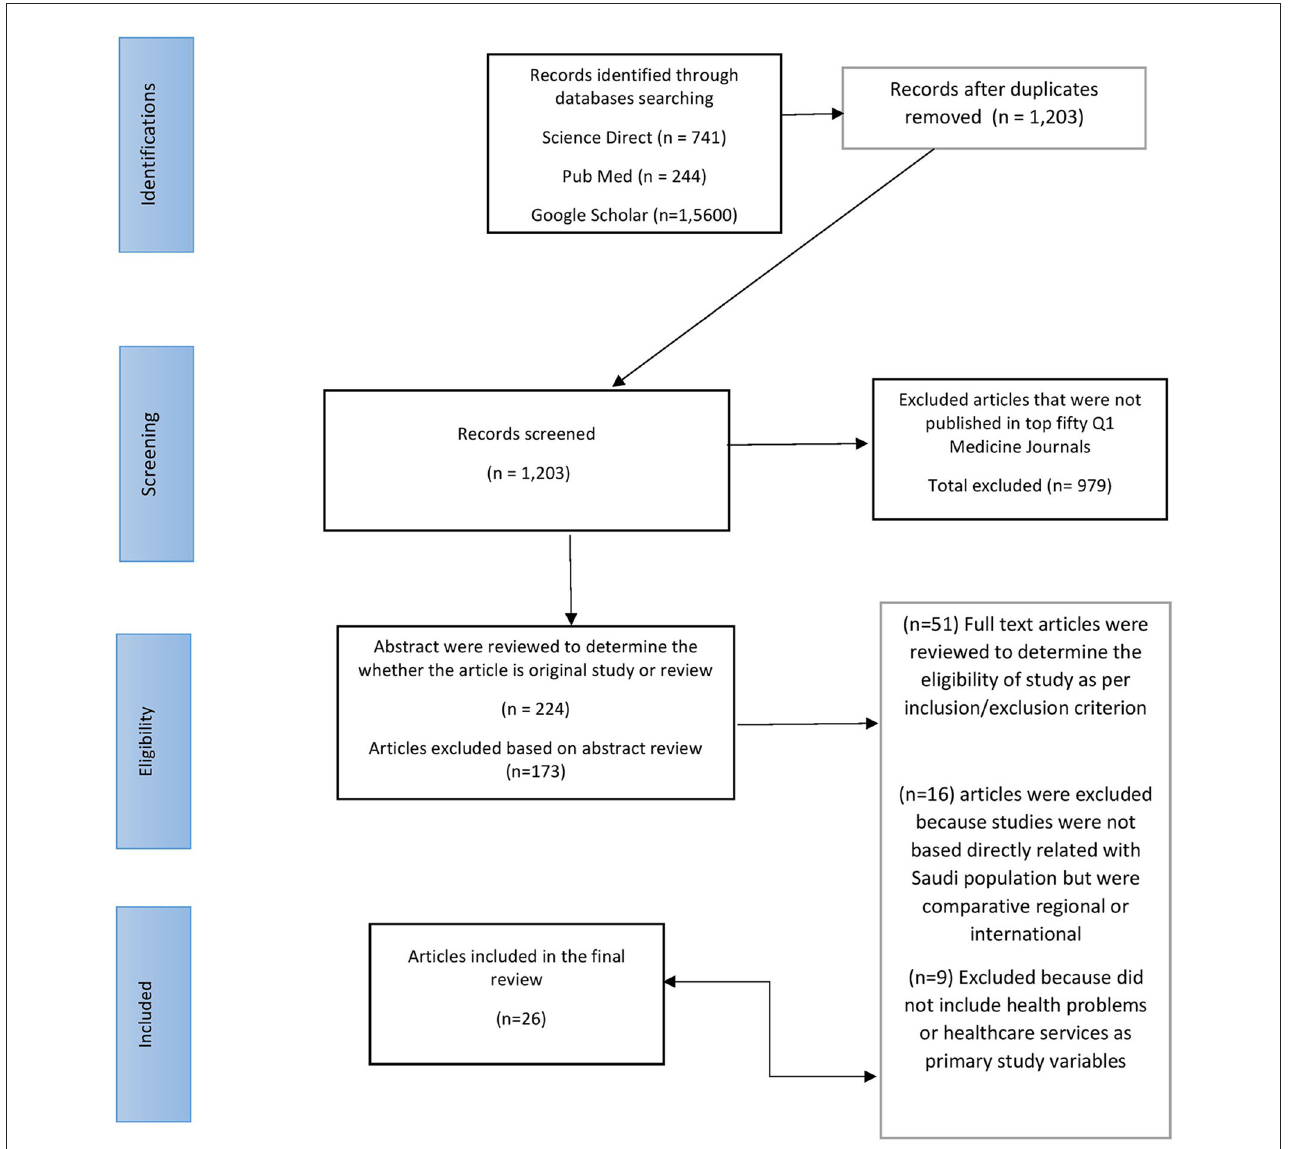
FIGURE1 Preferred reporting items for systematic reviews and meta-analyses (PRISMA) flow